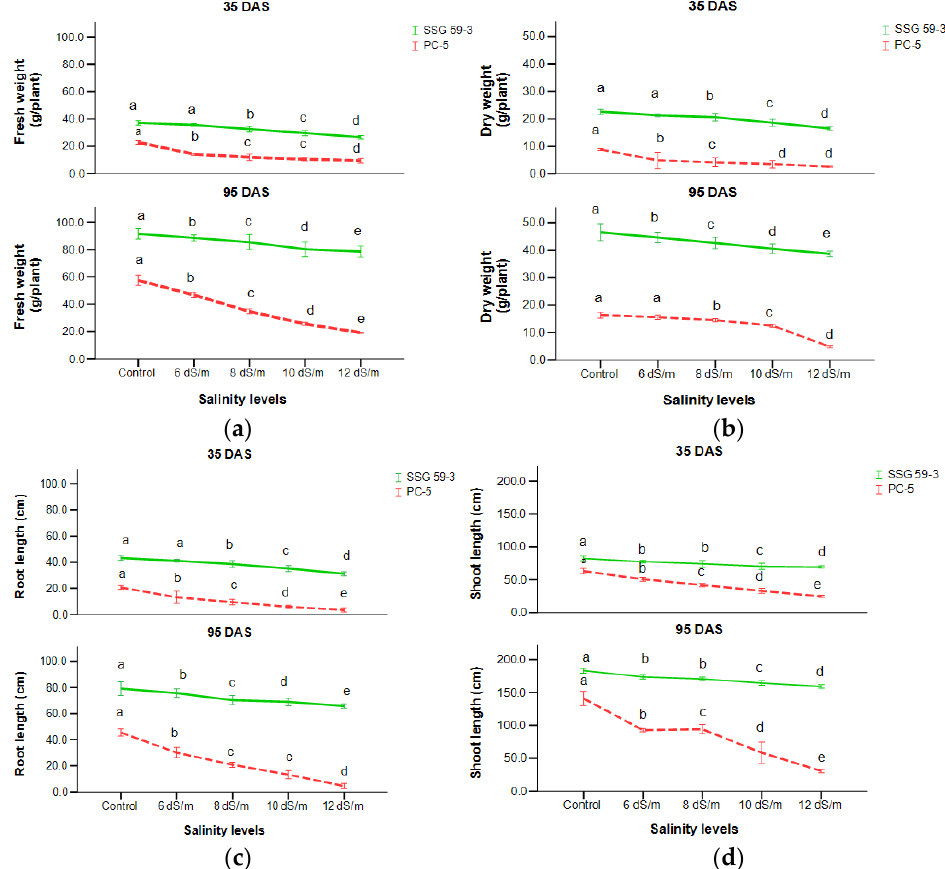
Figure 2. Effect of salt stress on ( a ) fresh weight, ( b ) dry weight, ( c ) root length, and ( d ) shoot length of sorghum genotypes at 35 and 95 DAS. Post hoc comparisons of the means were performed using Tukey’s HSD test at p < 0.05; different letters ( a–e ) indicate significant differences among treatments within each genotype.